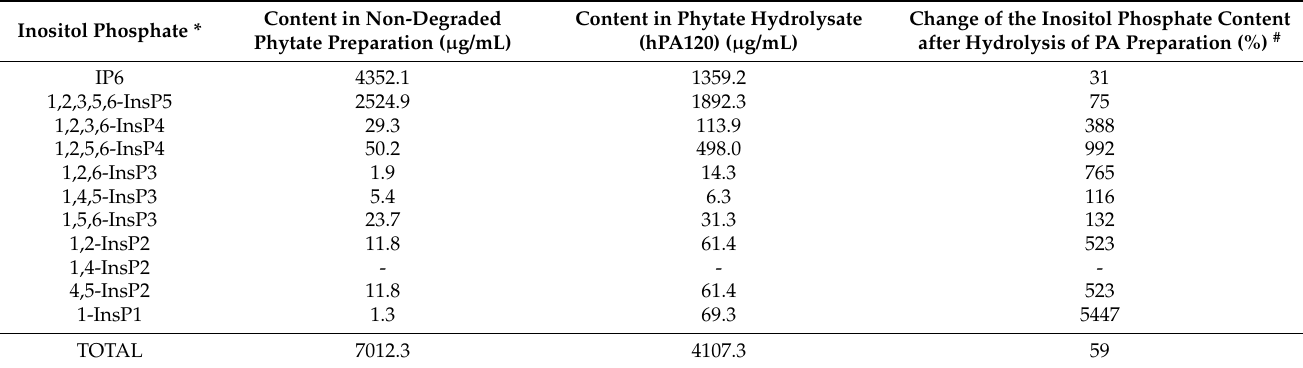
Table 1. Composition of the phytate hydrolysate (hPA120).